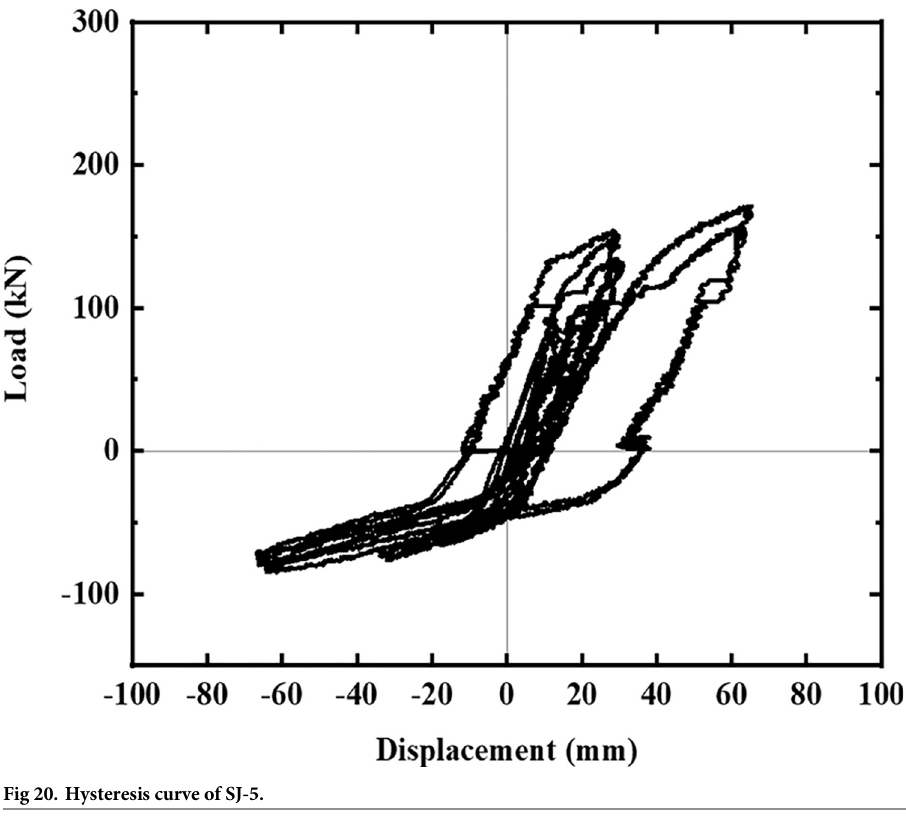
Fig 20. Hysteresis curve of